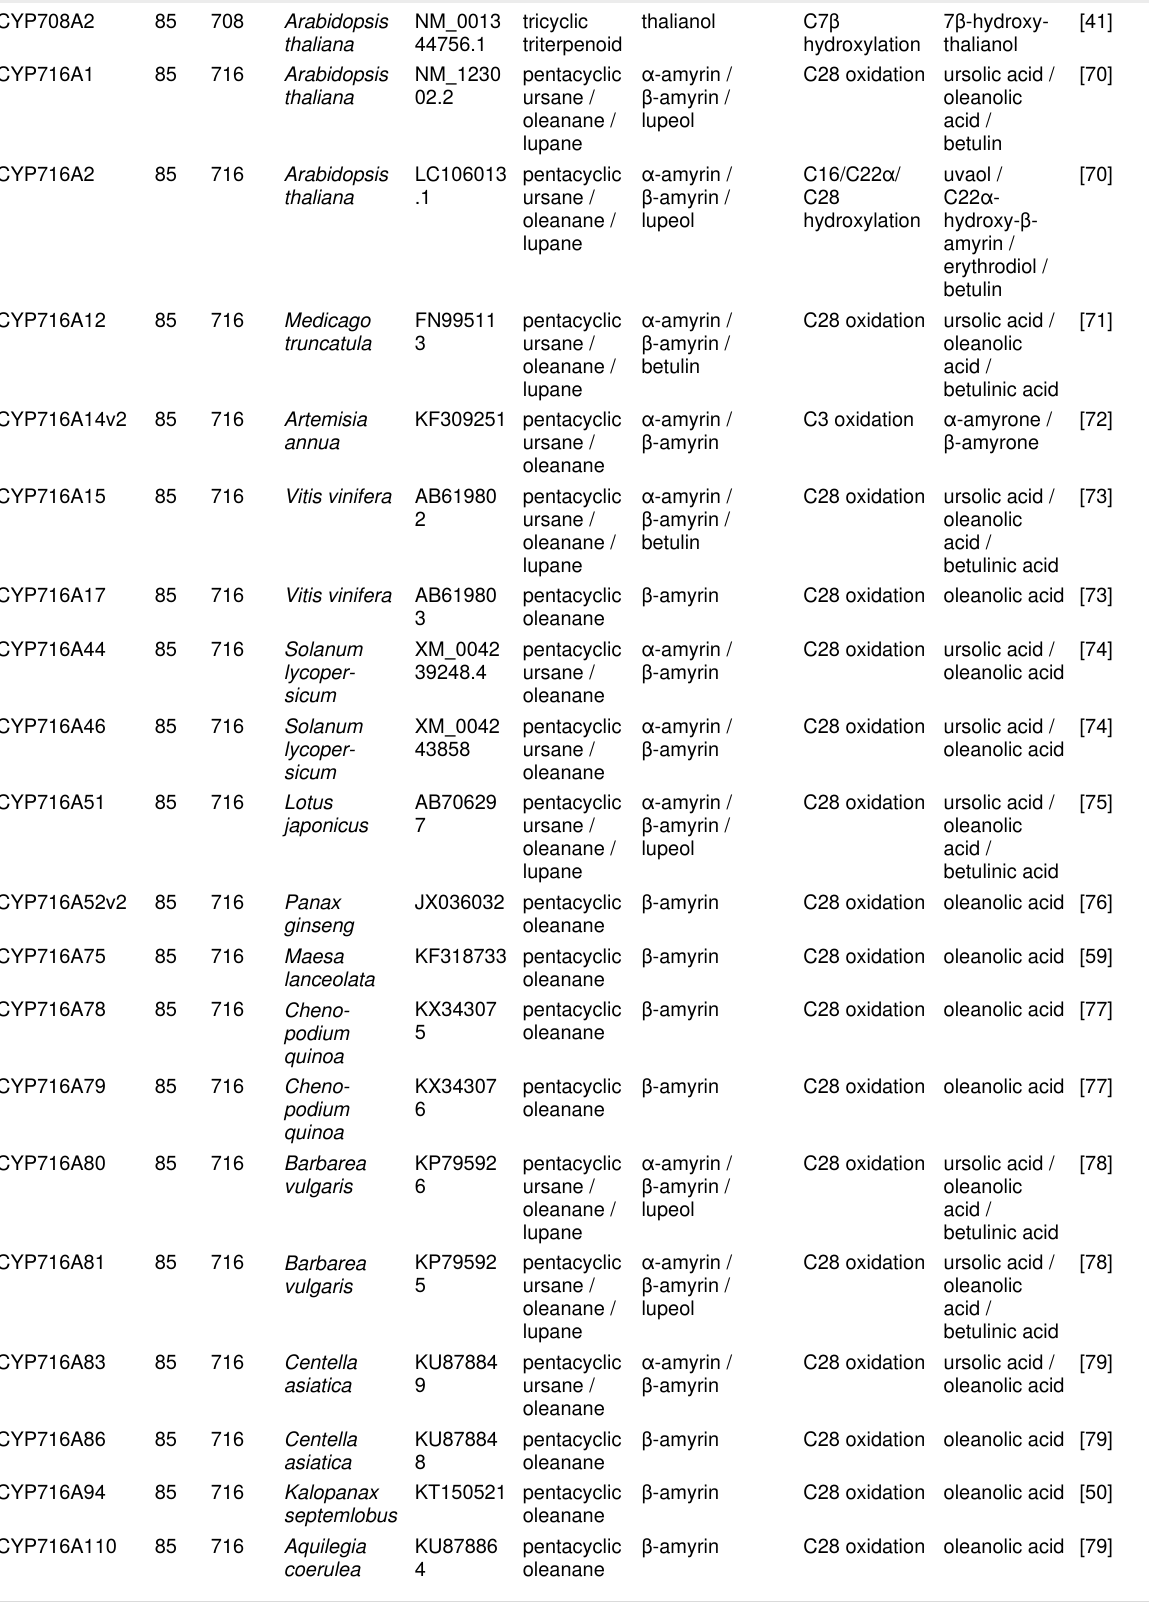
Table 1: List of characterised plant cytochrome P450 monooxygenases (CYPs) modifying triterpenoids or steroids. (continued)